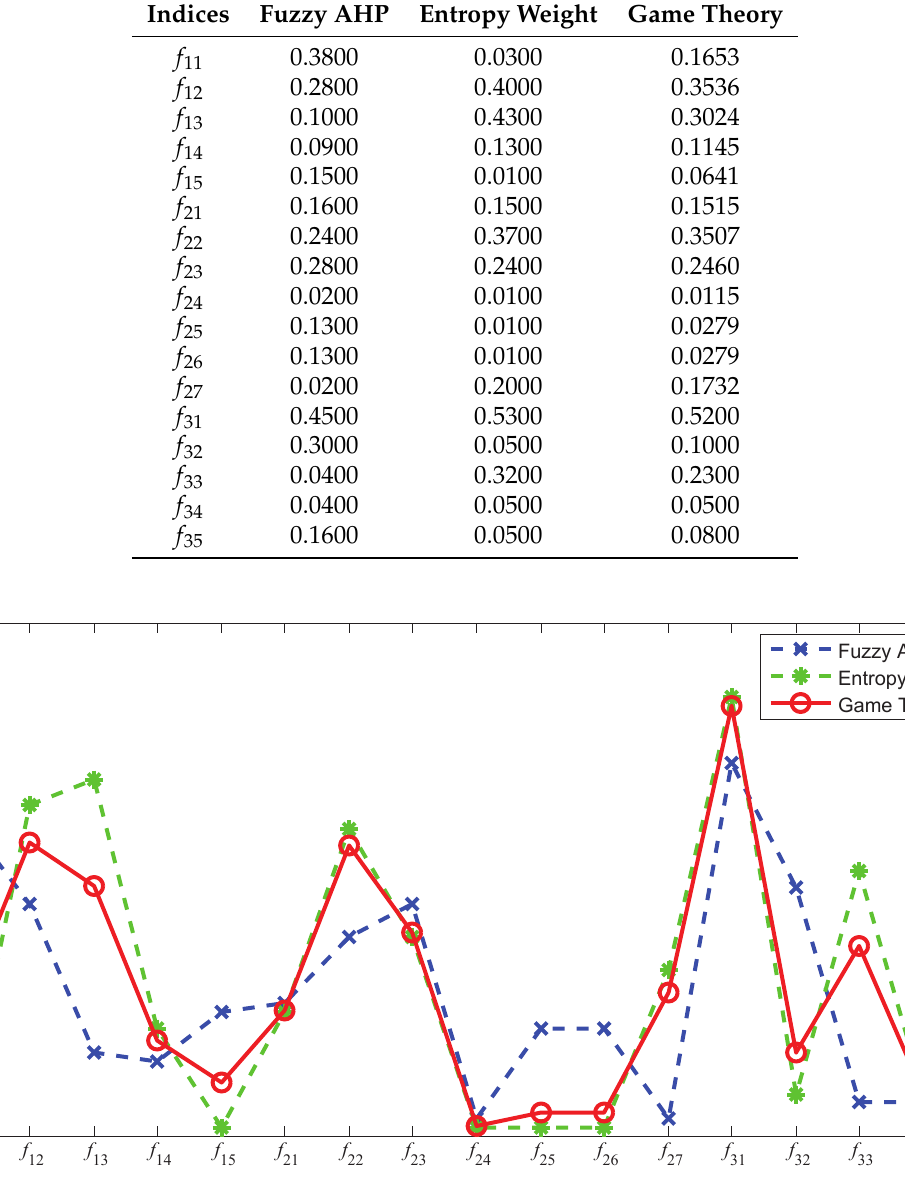
Table 5. Weights of indices.